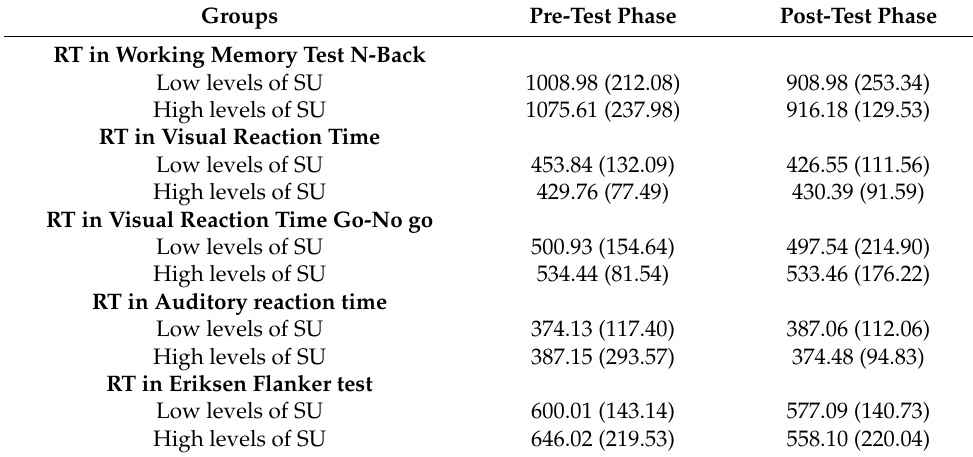
Table 2. Means (and standard deviations) on cognitive tests of groups with low levels of smartphone usage and with high levels of smartphone usage (SU).